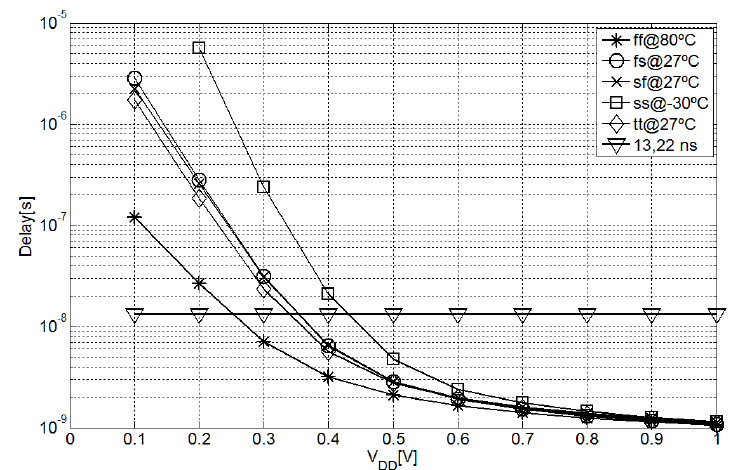
Figure 3. Cumulative inverter and subtractor delay in different fabrication corners with different supply